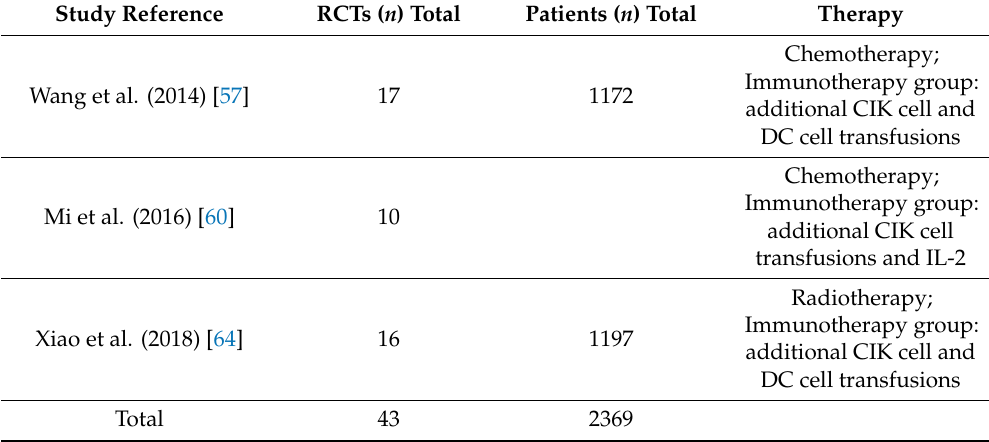
Table 3. Systematic reviews applying CIK cell and DC cell for the treatment of